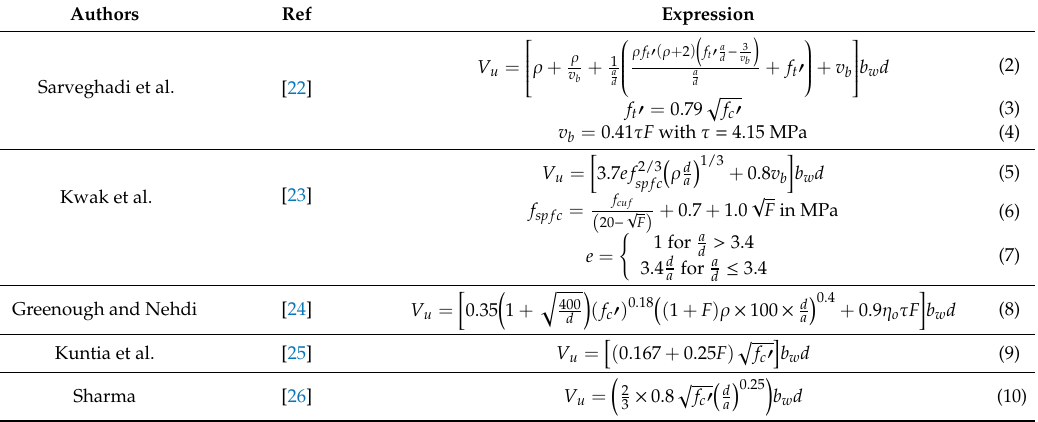
Table 1. Shear prediction equations from literature and available codes, adapted from